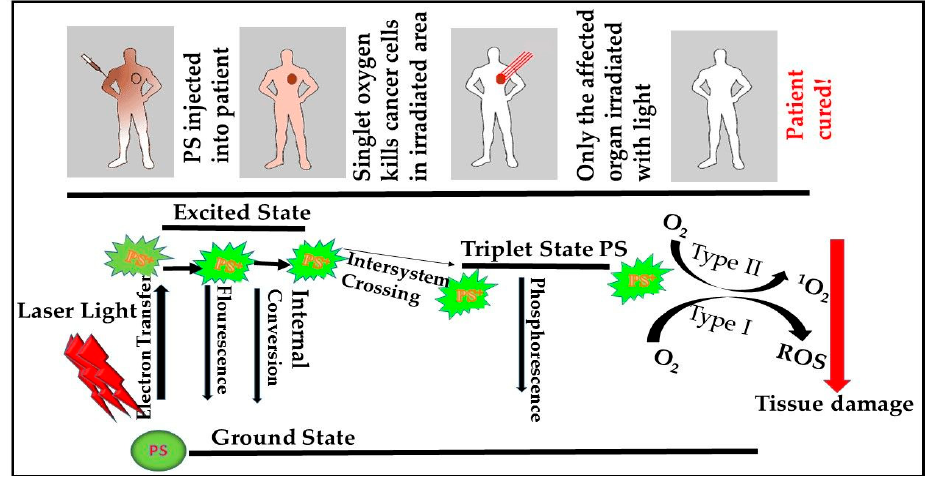
Figure 1. Schematic model of the Mechanism of Photodynamic Therapy (PDT), excitation and relaxation of a photosensitizer, and type I and type II photoreactions. Photosensitizers (PS) after an application as cream or injected become activated by light at specific wavelengths in the presence of oxygen (O 2 ). When activated they become excited and move from the singlet state to the triple state generating cytotoxic reactions. Some of the phytophysical reactions include electron transfer, fluorescence, internal conversion, intersystem crossing, and phosphorescence. These reactions directly generate singlet oxygen ( 1 O 2 ) or indirectly, reactive oxygen species (ROS) resulting in tissue damage and cell death [18].